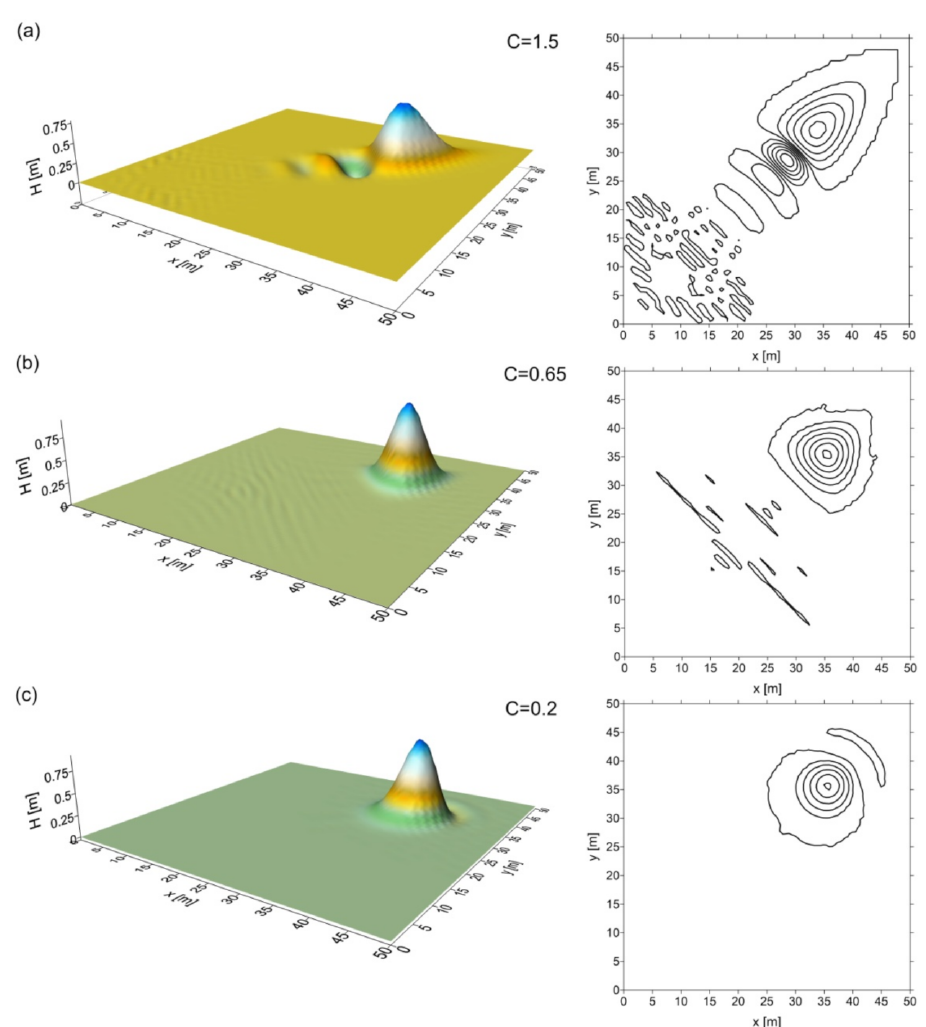
Figure 12. Solution obtained using the 8N mesh with θ = 1/2 and α = 1/3 for various values of the Courant number: ( a ) C = 1.5; ( b ) C = 0.65; ( c ) C =